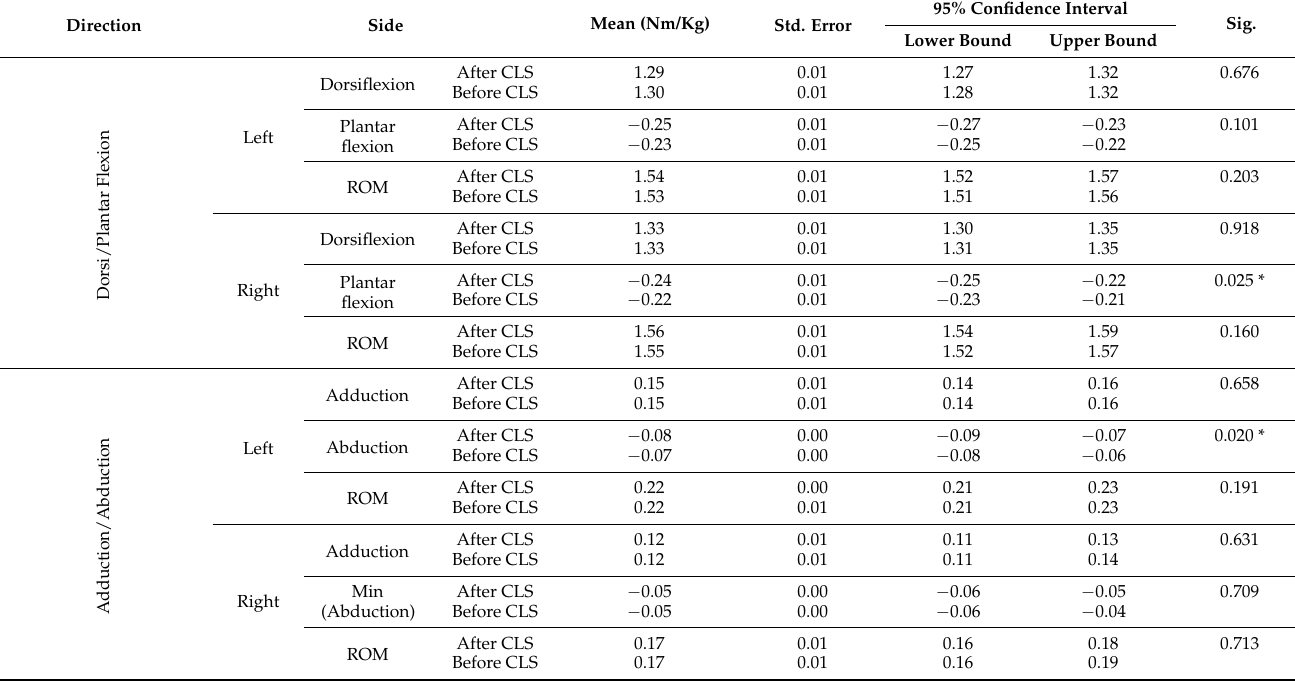
Ankle Joint Moment in Dorsi/Plantar Flexion, Adduction/Abduction, and Inter- nal/External Rotation